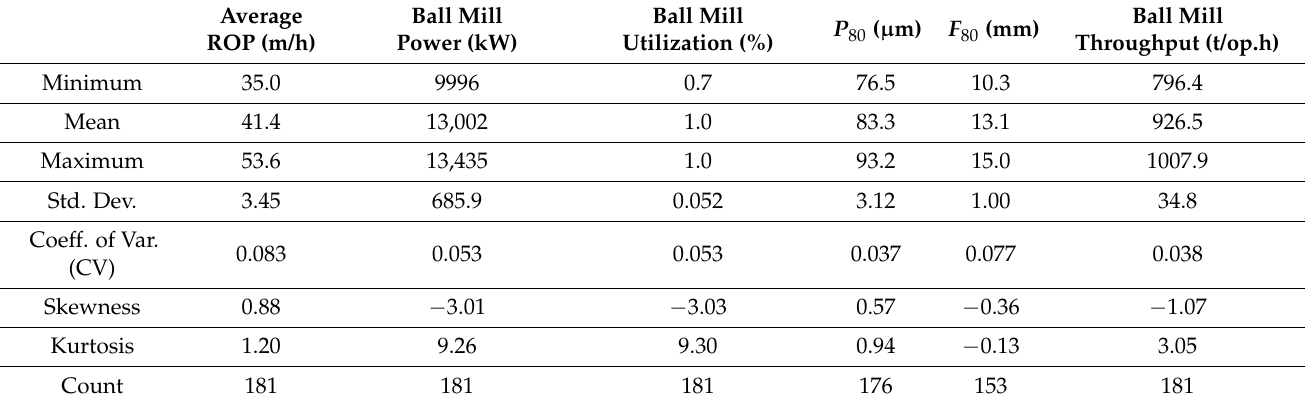
Table 1. Univariate statistics of predictive variables (features) and ball mill throughput